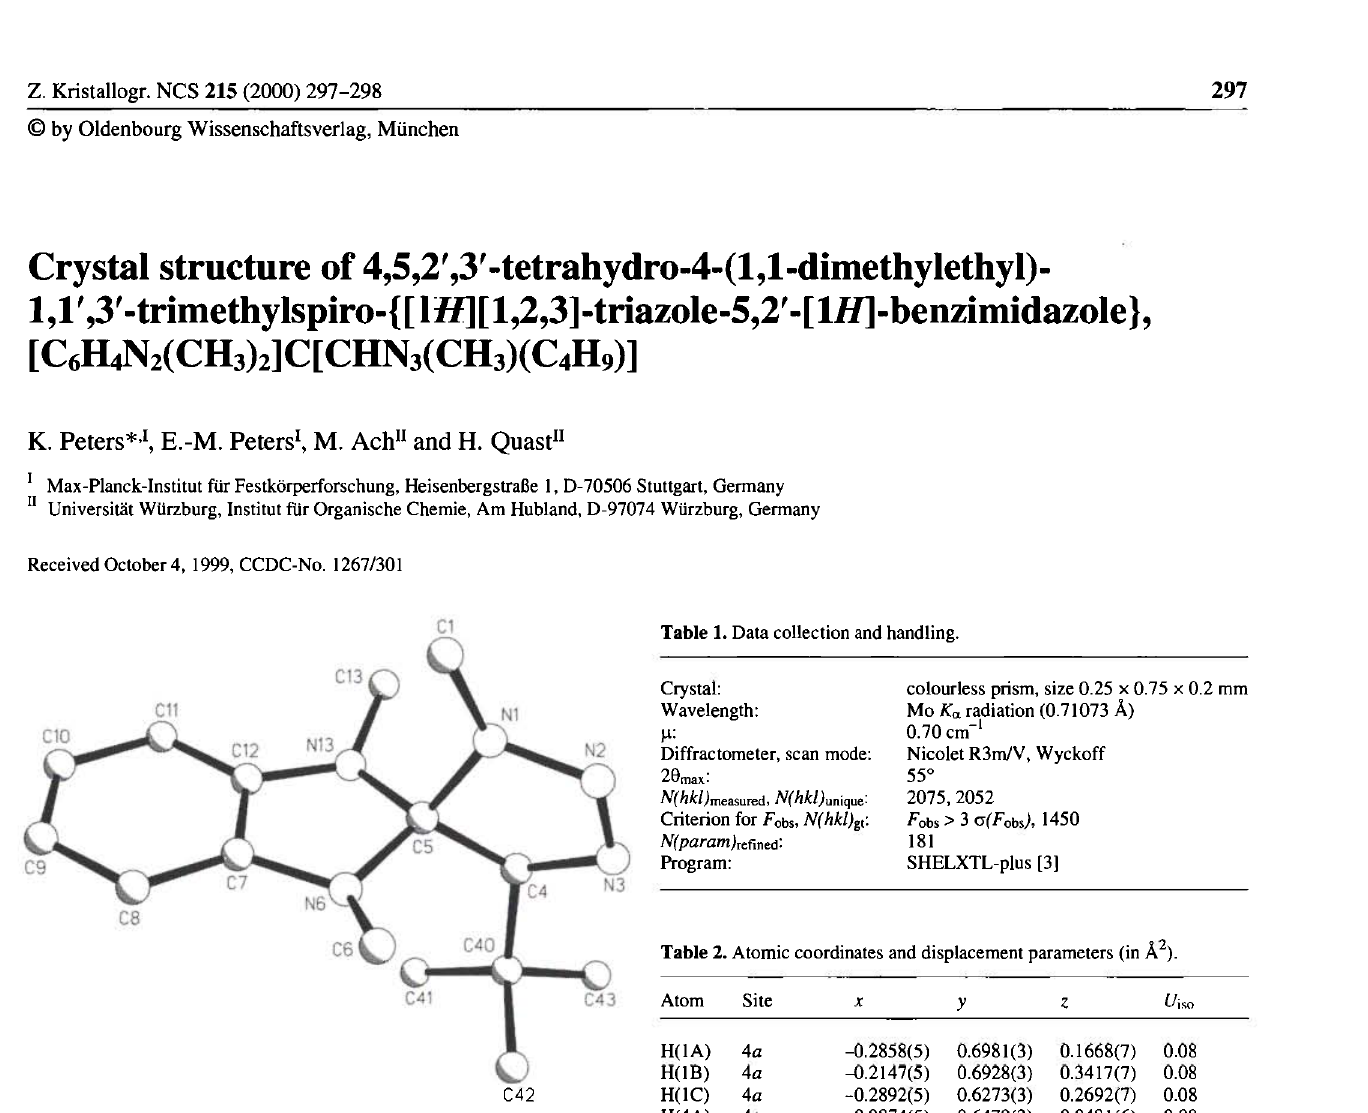
Table 2. Atomic coordinates and displacement parameters (in Ä 2